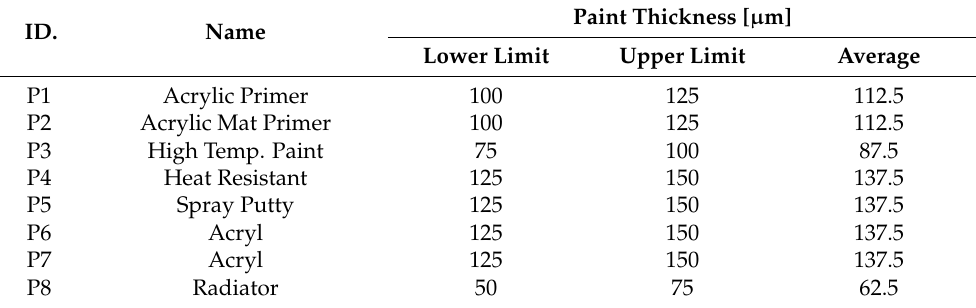
Table 4. Results of the wet paint thickness